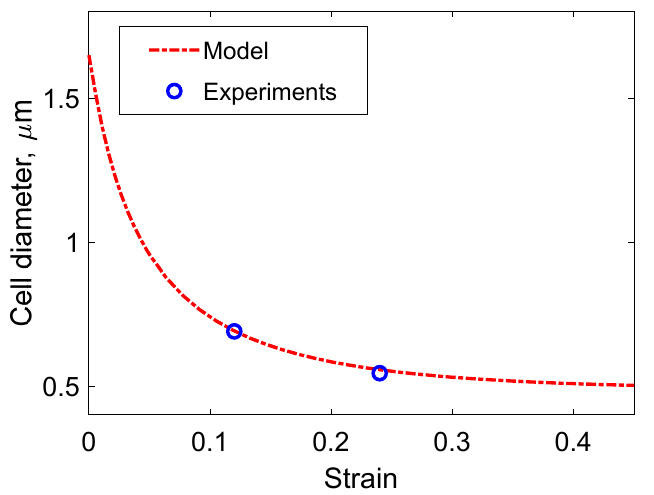
Figure 5. Cell diameters as a function of strain for Cu-OFP at 75 °C and 1 × 10 − 5 1/s. Experimental data from [3]. Redrawn with permission from ref. [16]. Copyright 2022 Elsevier. Dislocation locks are formed in the boundaries, which are stabilized by the